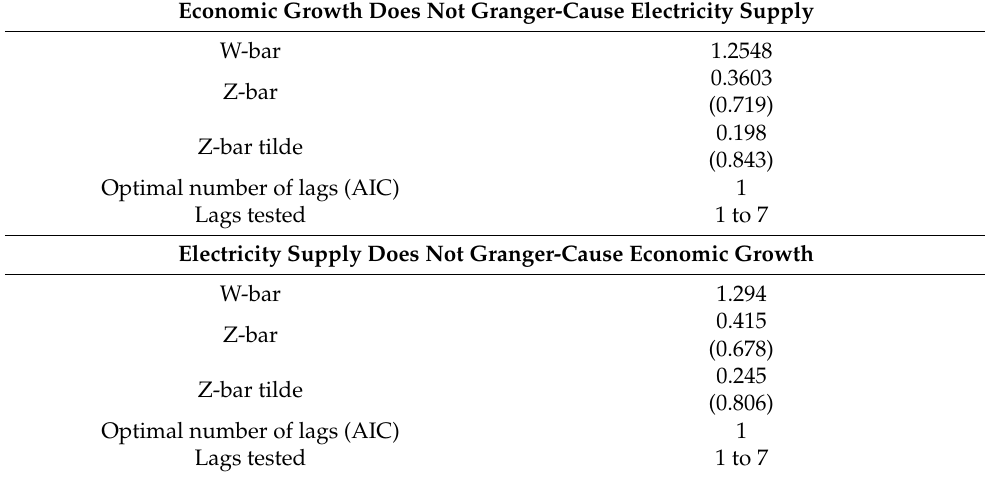
Table 5. DH Granger non-causality test